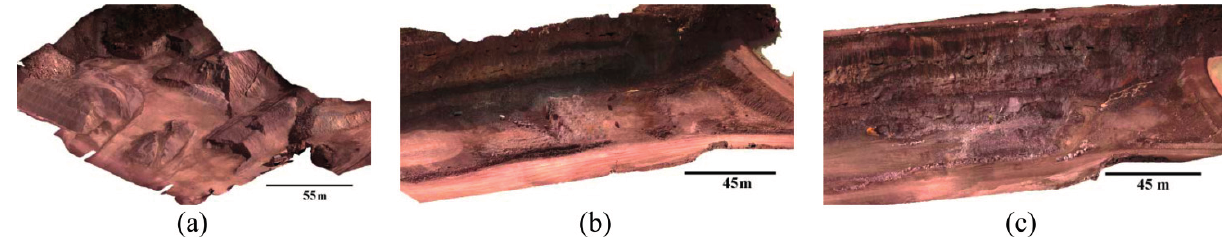
Figure 12. Triangulated mesh for ( a ) Dataset A; ( b ) Dataset B after shadow removal; ( c ) Dataset